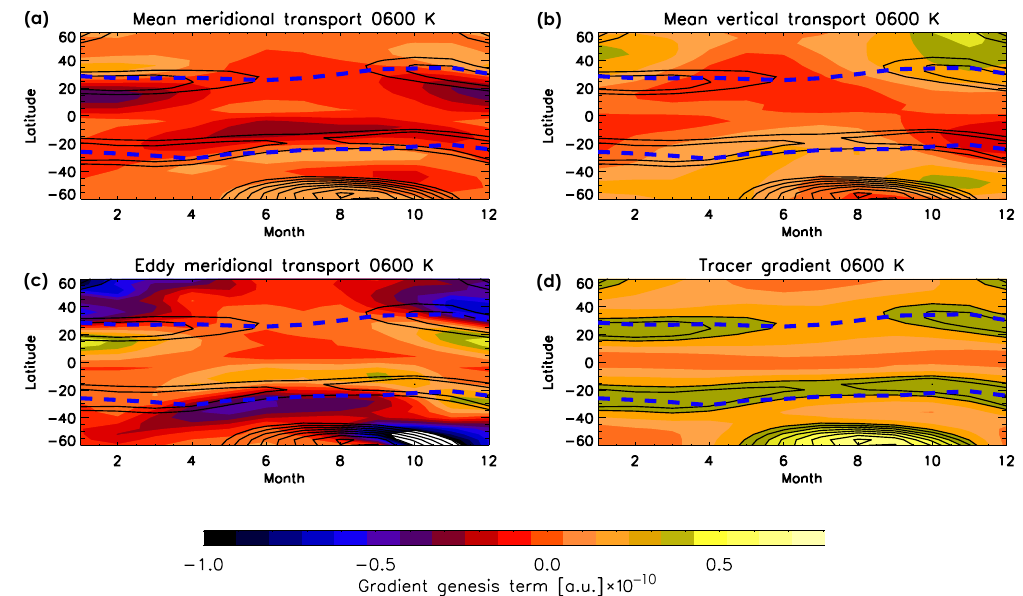
Figure A3. Seasonal variation at 600K of the gradient genesis terms according to Fig. 8 of Miyazaki and Iwasaki (2008) from multi-annual means derived from CLaMS data and ERA-Interim reanalyses; the colour coding indicates the values of the gradient genesis terms. (a) Mean meridional transport; (b) mean vertical transport; (c) eddy meridional transport; (d) tracer gradient. The black solid contour lines mark the multi-annual mean regions of maximum tracer gradients and are the same in all four panels. The blue dashed lines show the transport barrier positions derived from CLaMS N 2 O